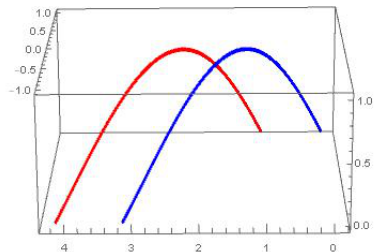
Figure 1. The blue curve is r ( s ) and the red one is ˜ r ( s )